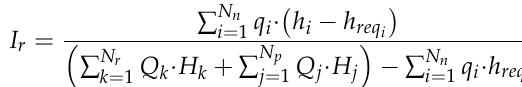
Figure 2. Hydraulic layout of Pumps as Turbines ( PAT) and by-pass.